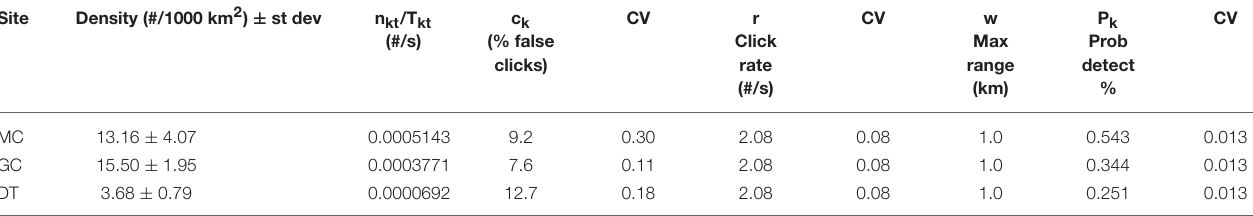
TABLE 4 | Average Kogia spp. densities derived from click counting by site (MC, GC, DT) given in # of animals per 1000 km 2 . Site